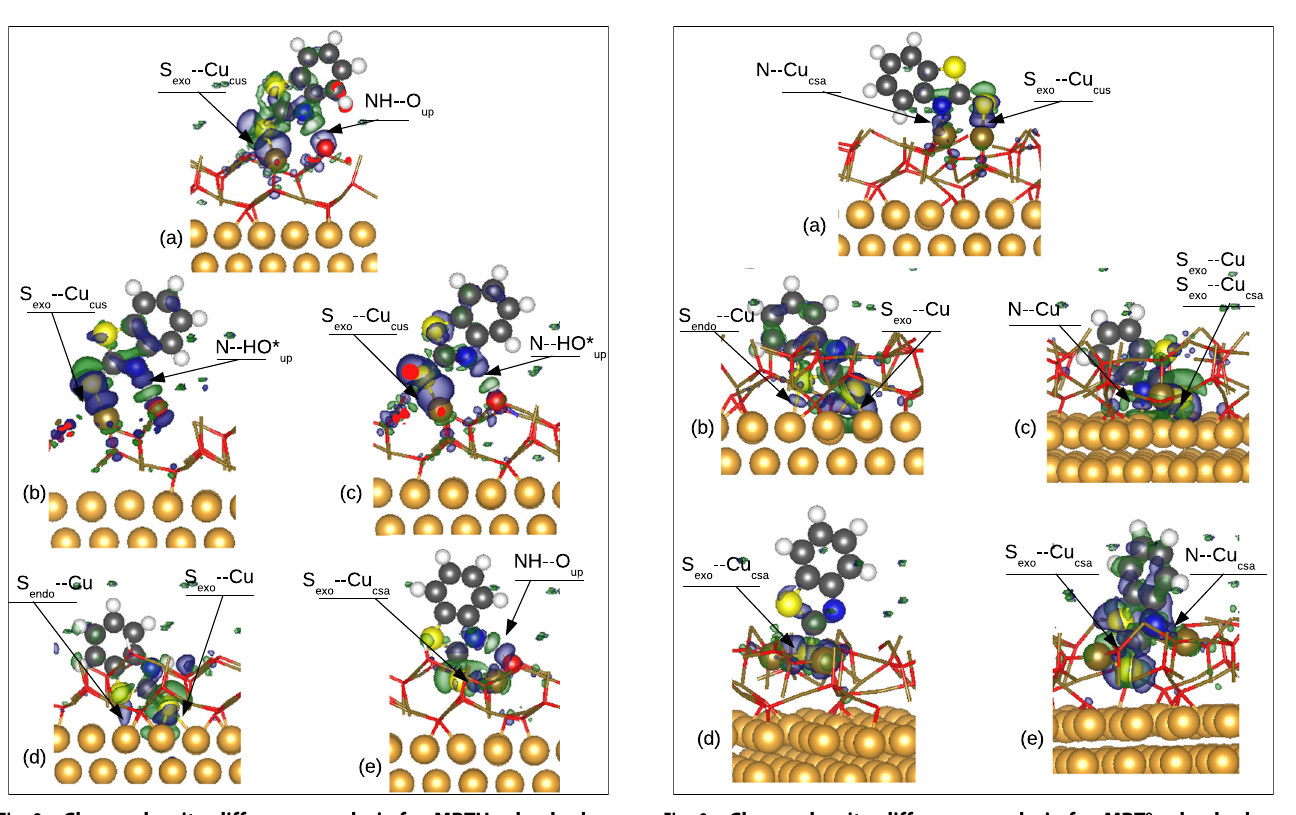
Fig. 8 Charge-density difference analysis for MBTH adsorbed on partially oxide-covered copper surface. a and b Snapshots on the oxide surface, c on the oxide edges, d on the metal surface, and e on the oxide wall. Light blue and green colors of isosurface correspond to accumulation and depletion of charge density, respectively.